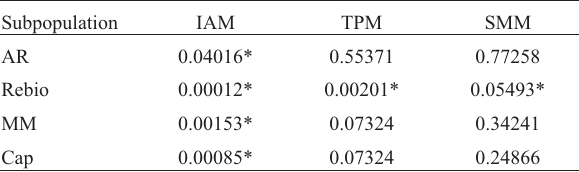
Table 1 - Wilcoxon test for E. ovata subpopulations with nSSR markers. Subpopulation